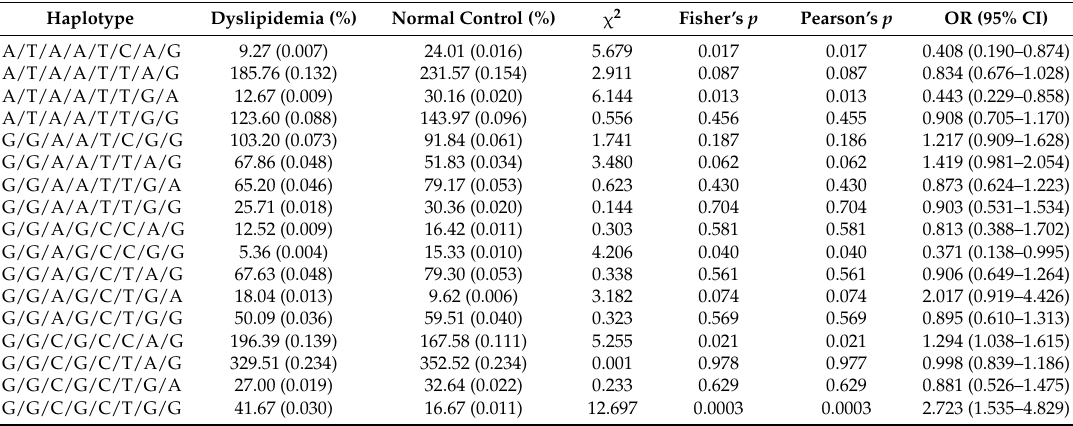
Table 5. The distribution of haplotypes of eight SNPs in CETP gene between the cases and controls in Xinjiang Minority